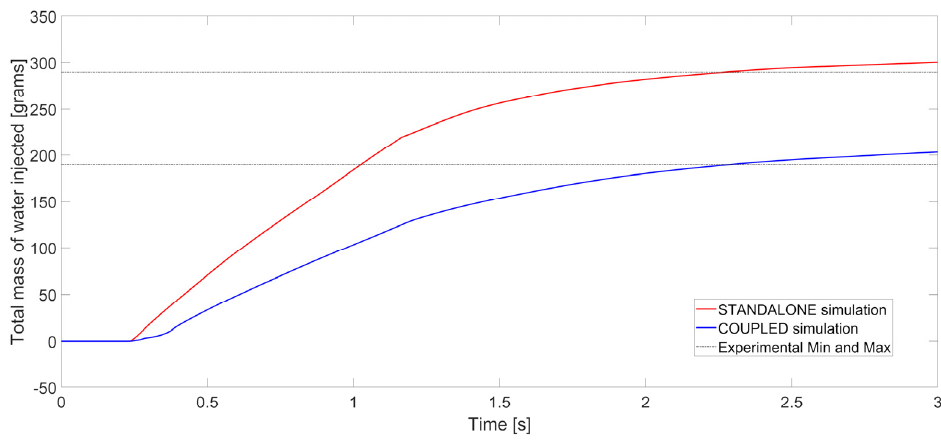
Figure 19. Standalone and Coupled simulations—liquid water mass flow rate in the injection line.